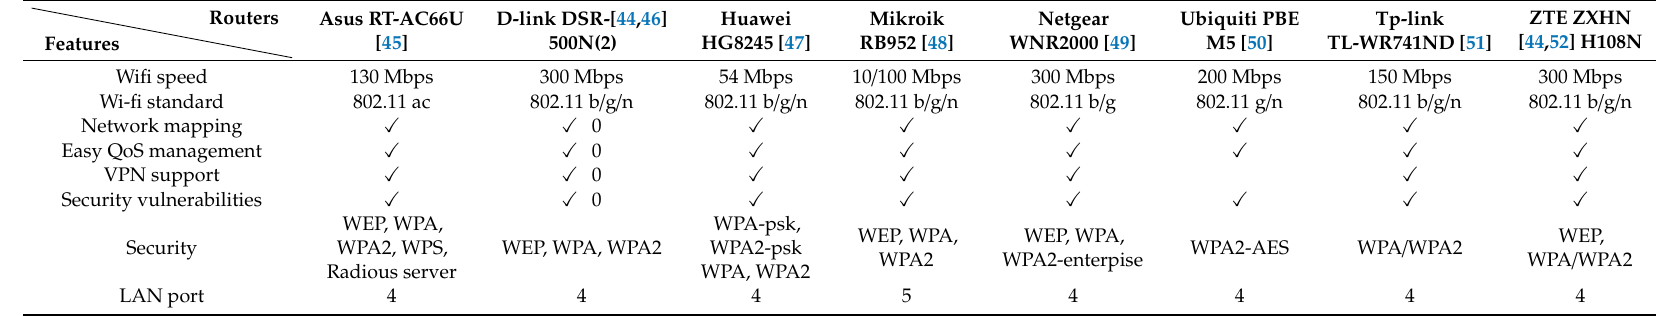
Table 2. Comparison of router